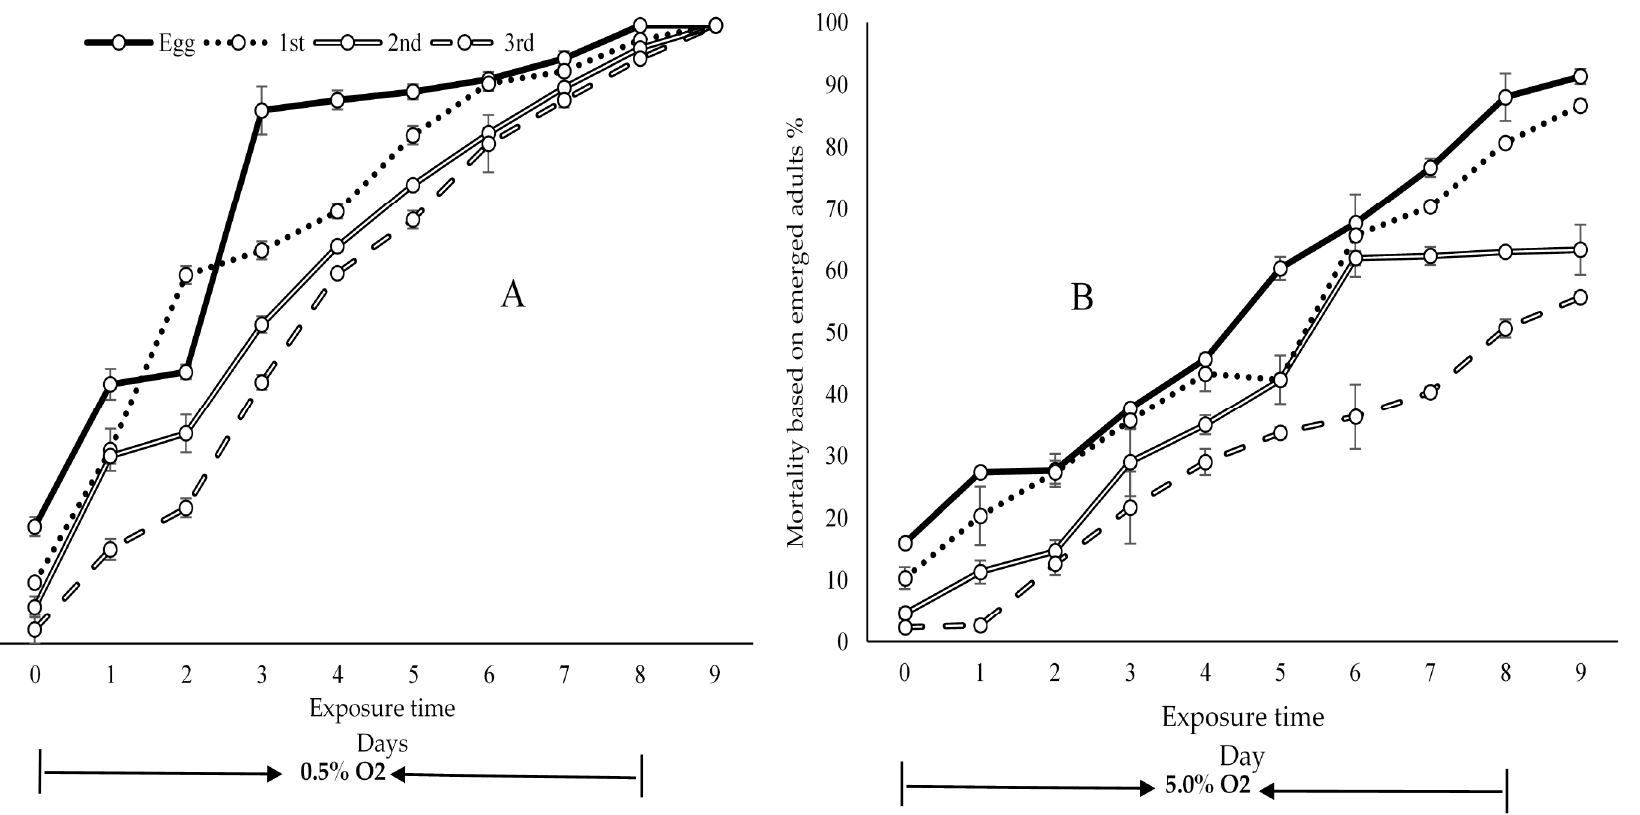
Figure 3. Mortality (SE) of eggs and 1st, 2nd and 3rd stage larvae based on emerged flies rate. ( A )—0.5% O 2 and ( B )—5.0% O 2.